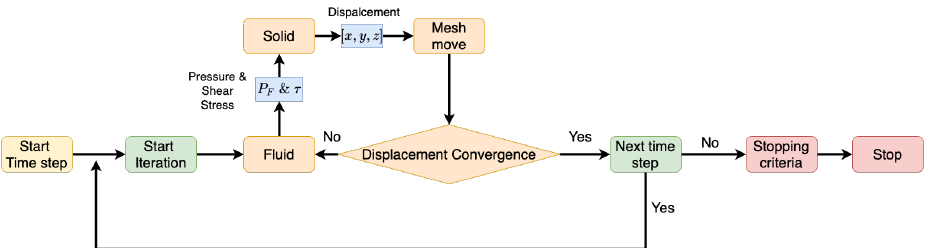
Figure 13. Fluid-Structure Interaction coupling routine where the dynamics of the flow is described using Computational Fluid Dynamic (CFD) and the Solid is characterized using Finite Element Analysis